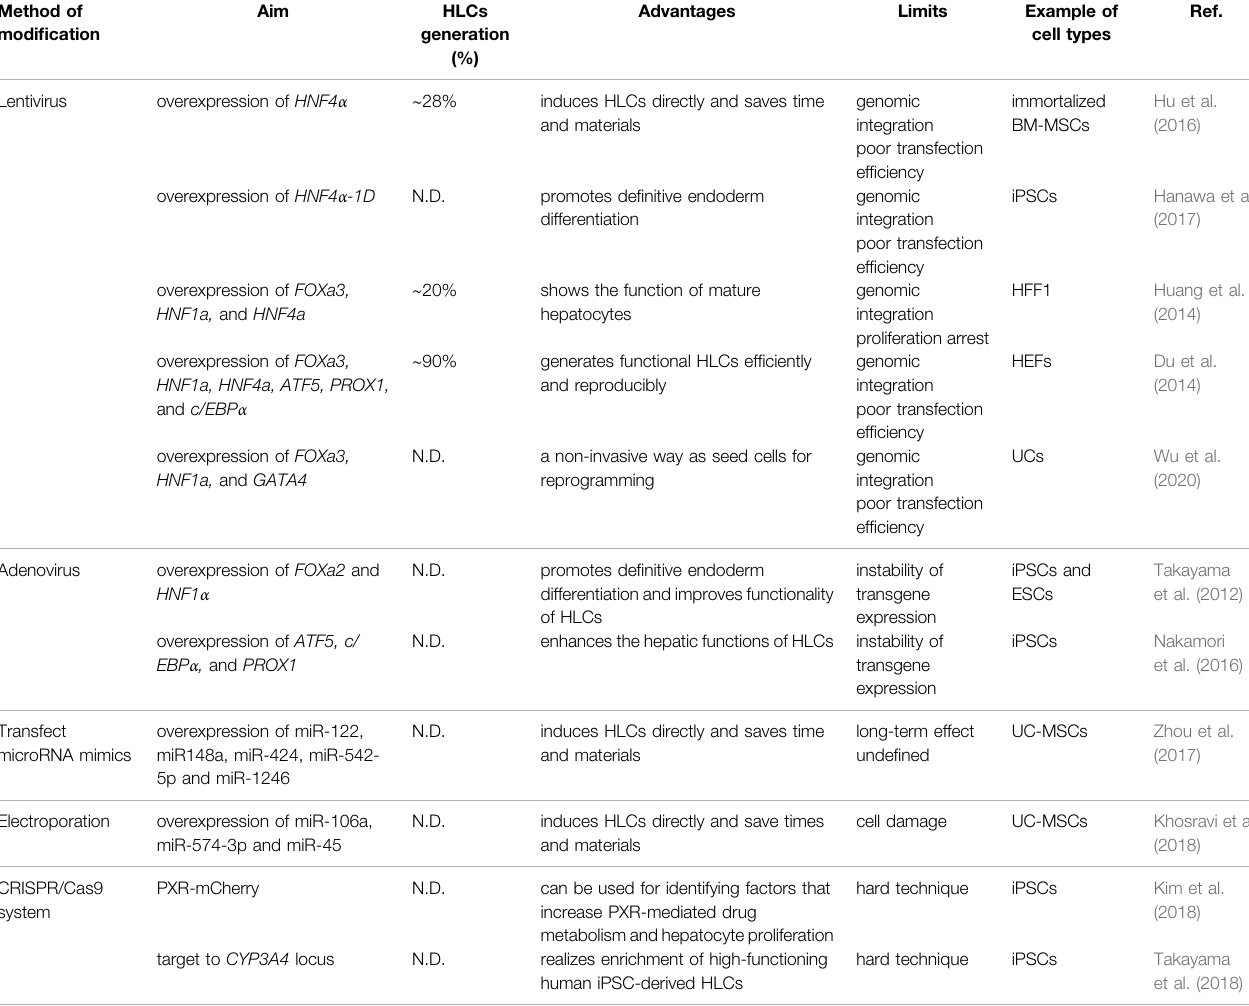
TABLE 3 | Application of gene editing technology in human HLCs